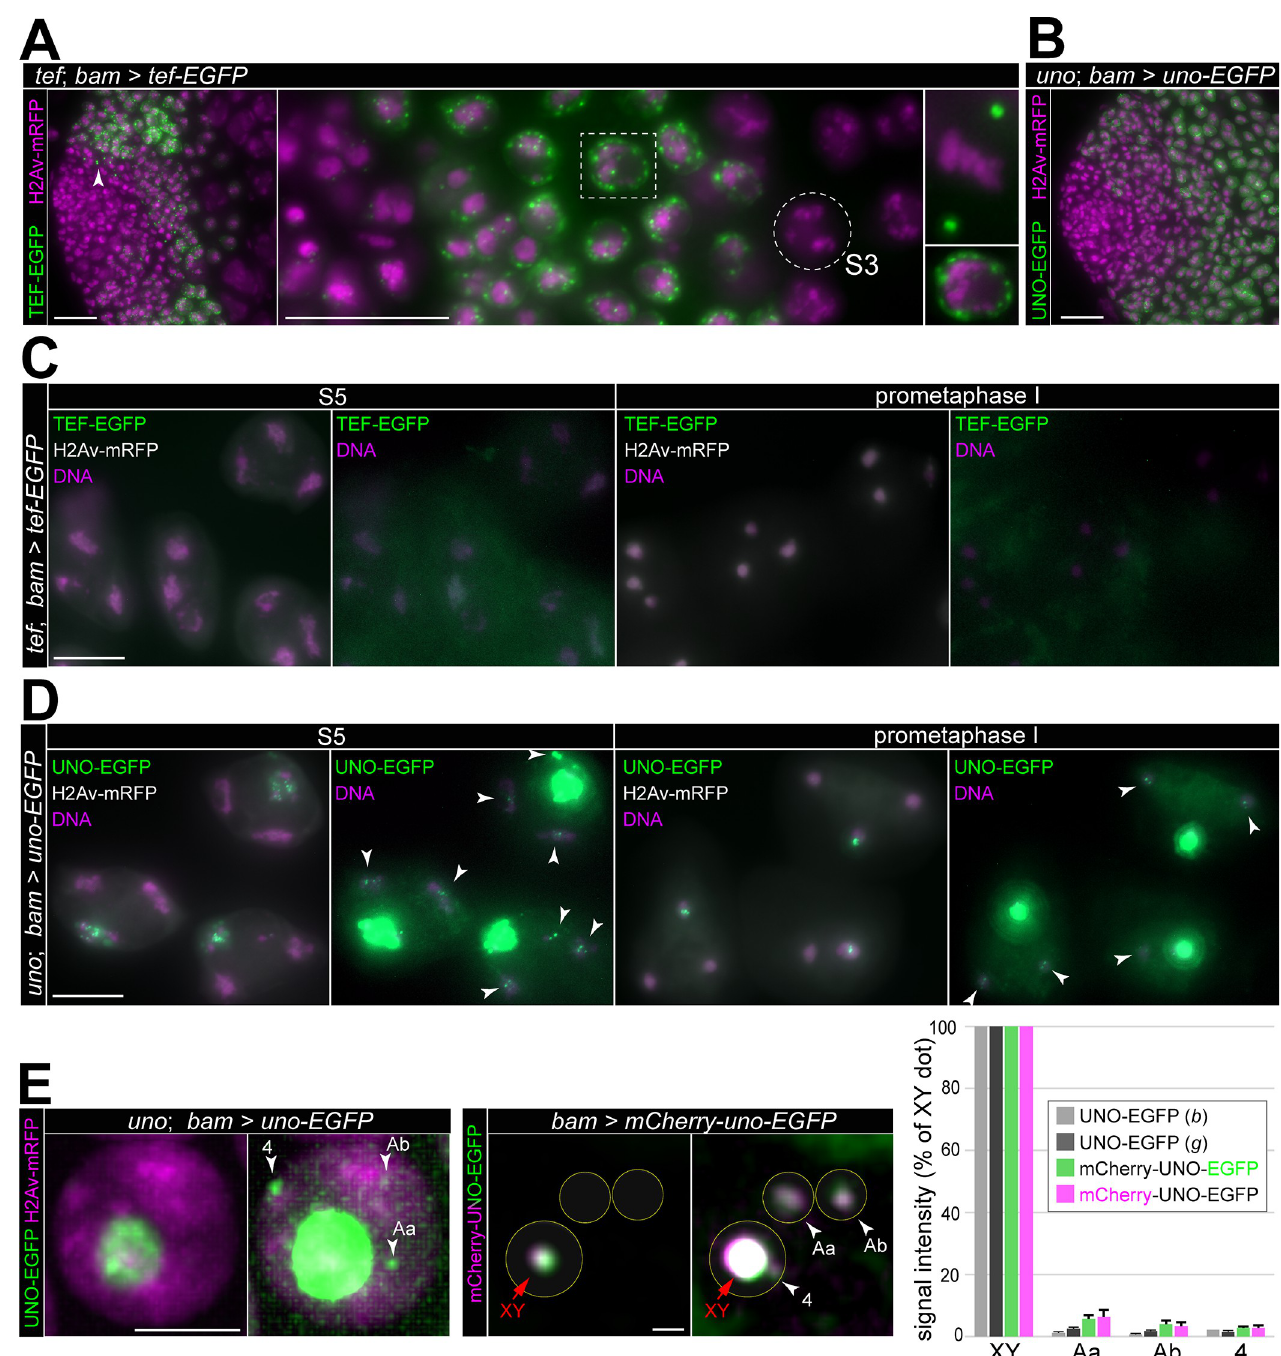
Fig 3. TEF-EGFP is not stably bound on autosomal bivalents until anaphase I in contrast to UNO-EGFP. ( A-D ) Analysis of genotypes, in which the expression of endogenous UNO and TEF was replaced by UNO-EGFP and TEF-EGFP, respectively, using UASt transgenes and bamP-GAL4-VP16 . Apical testis regions (A,B) and late spermatocytes (C,D) are displayed. ( A ) TEF-EGFP is detectable only transiently in tef mutants with bam > tef-EGFP . During the last spermatogonial mitosis, TEF-EGFP is on spindle poles (arrowhead left panel, high magnification upper right panel) and in the following interphase granular around chromatin (equatorial section of nucleus boxed in middle panel displayed in lower right panel). At the S3 stage (circled in middle panel), TEF-EGFP is no longer detectable. ( B ) UNO-EGFP signals are maintained during spermatocyte maturation in uno mutants with bam > uno-EGFP . ( C ) TEF-EGFP signals are not detectable on bivalents in images acquired and displayed as those in (D). ( D ) UNO-EGFP signals on chrXY and autosomal bivalents. For a given stage, the same image is shown twice with distinct display settings, on the left without saturation of the UNO-EGFP signals on chrXY pairing region on the right with strong enhancement of the green channel to reveal the much weaker UNO-EGFP signals on autosomal bivalents (arrowheads). ( E ) Comparison of UNO